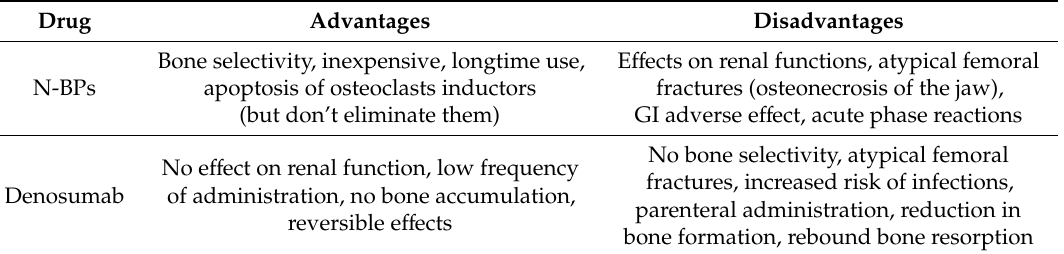
Table 5. Characteristics of the two main classes of antiresorptives